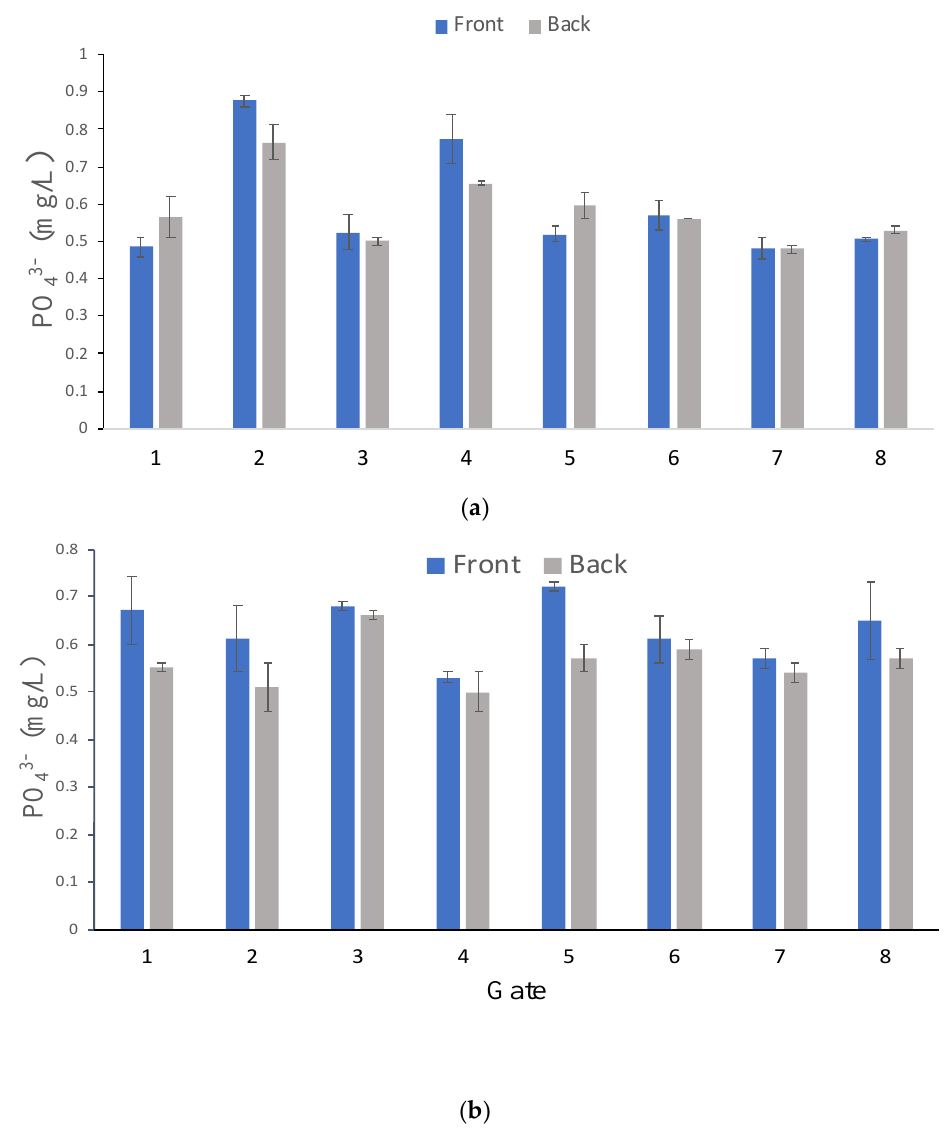
Figure 4. mg PO 43- /L in front of and after treatment gates on ( a ) 2 June 2020 and ( b ) 8 September 2020 to show changes through Eckert’s Ditch. Error bars are standard deviation of triplicate samples. Table 3. Percent of cartridge area below water level at time of sampling.